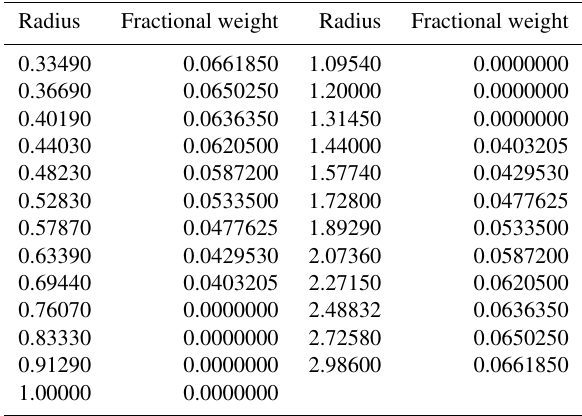
Table A2. Axis ratio distribution for the spheroidal dust particles (Dubovik et al., 2006). Radius Fractional